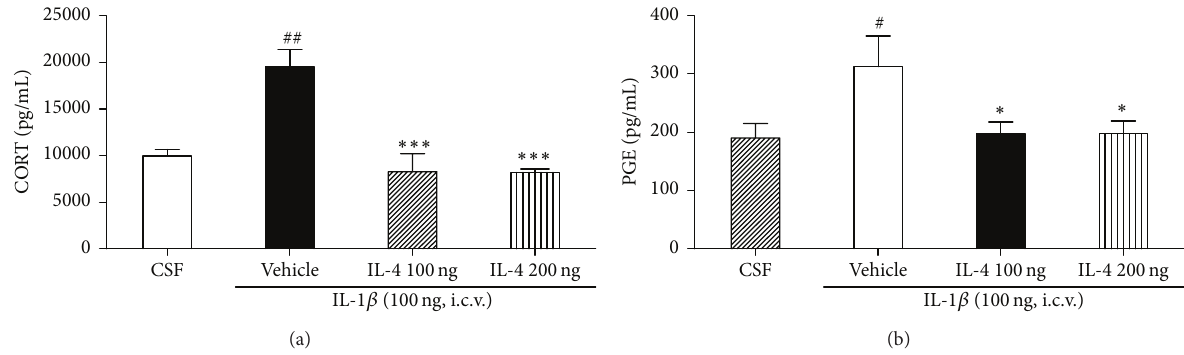
Figure 2: (a) Effect of IL-4 injected 2 hours after injection of i.c.v. IL-1 𝛽 on CORT concentration. Each value represents the mean ± SEM. ## 𝑃 < 0.01 compared to the CSF and ∗∗∗ 𝑃 < 0.001 compared to the IL-1 𝛽 treated group. Control, 𝑛 = 5 ; IL-1 𝛽 , 𝑛 = 5 ; IL-4 100 ng, 𝑛 = 5 ; IL-4 200 ng, 𝑛 = 5 . (b) Effect of IL-4 injection 2 hours after injection of i.c.v. IL-1 𝛽 on PGE 2 concentration. Each value represents the mean ± SEM. The results of ELISA were analyzed by performing separate one-way ANOVA among the groups. Each value represents the mean ± SEM. # 𝑃 < 0.05 compared to the CSF and ∗ 𝑃 < 0.05 compared to the IL-1 𝛽 treated group. Control, 𝑛 = 5 ; IL-1 𝛽 , 𝑛 = 5 ; IL-4 100ng, 𝑛 = 5 ; IL-4 200 ng, 𝑛 = 5